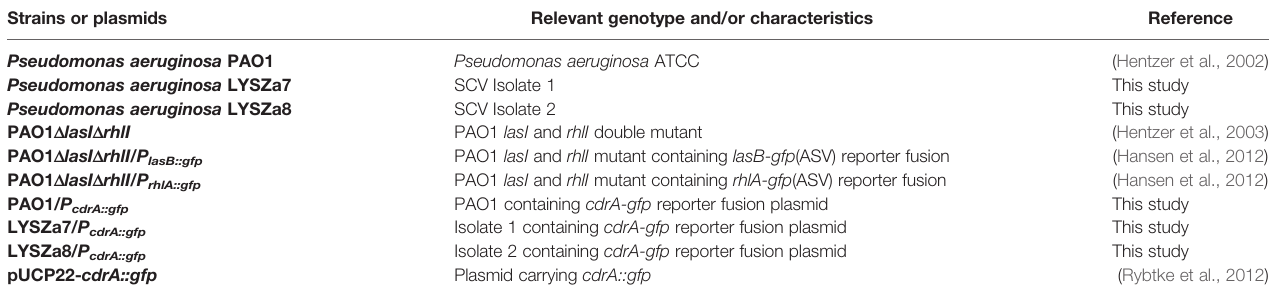
TABLE 1 | Bacteria strains and plasmid used in this